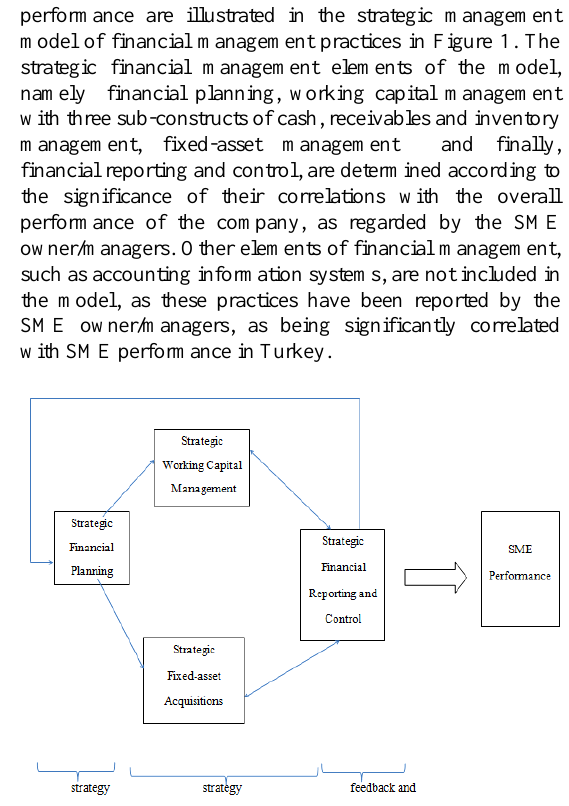
Figure 1. Within the three basic phases of strategic